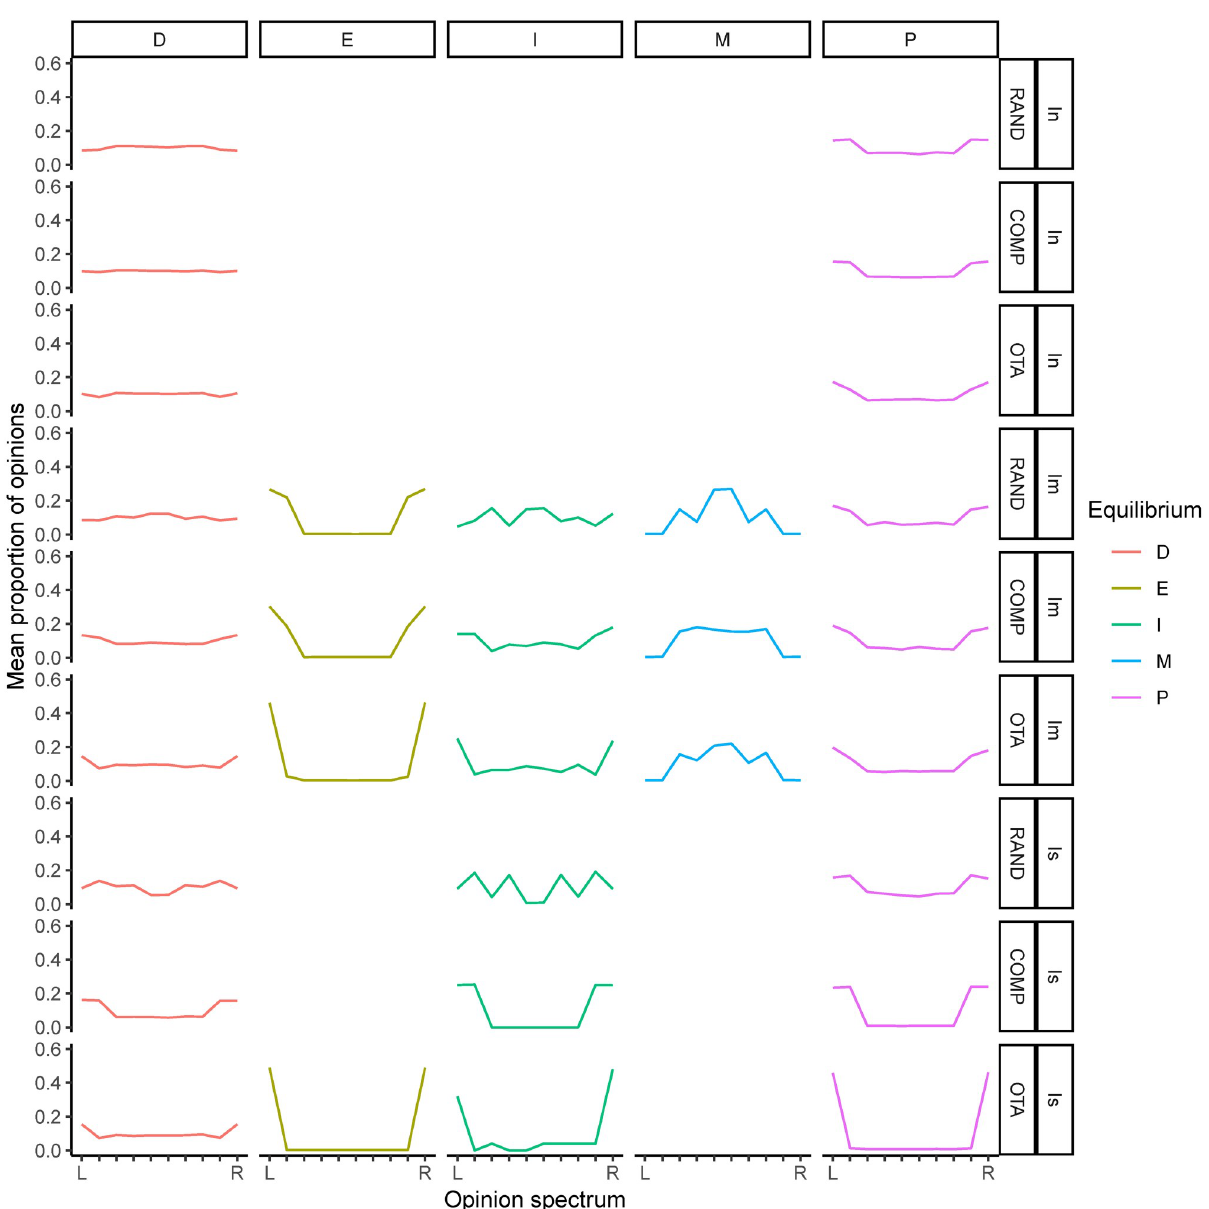
Fig 9. Mean proportion of opinions under value-aggregating institutions in each type of opinion equilibrium by condition after 2000 simulations. We exclude low frequency events (which may reduce the reliability of the opinion distribution and lead to higher margin of error) by removing any output that occurs less than